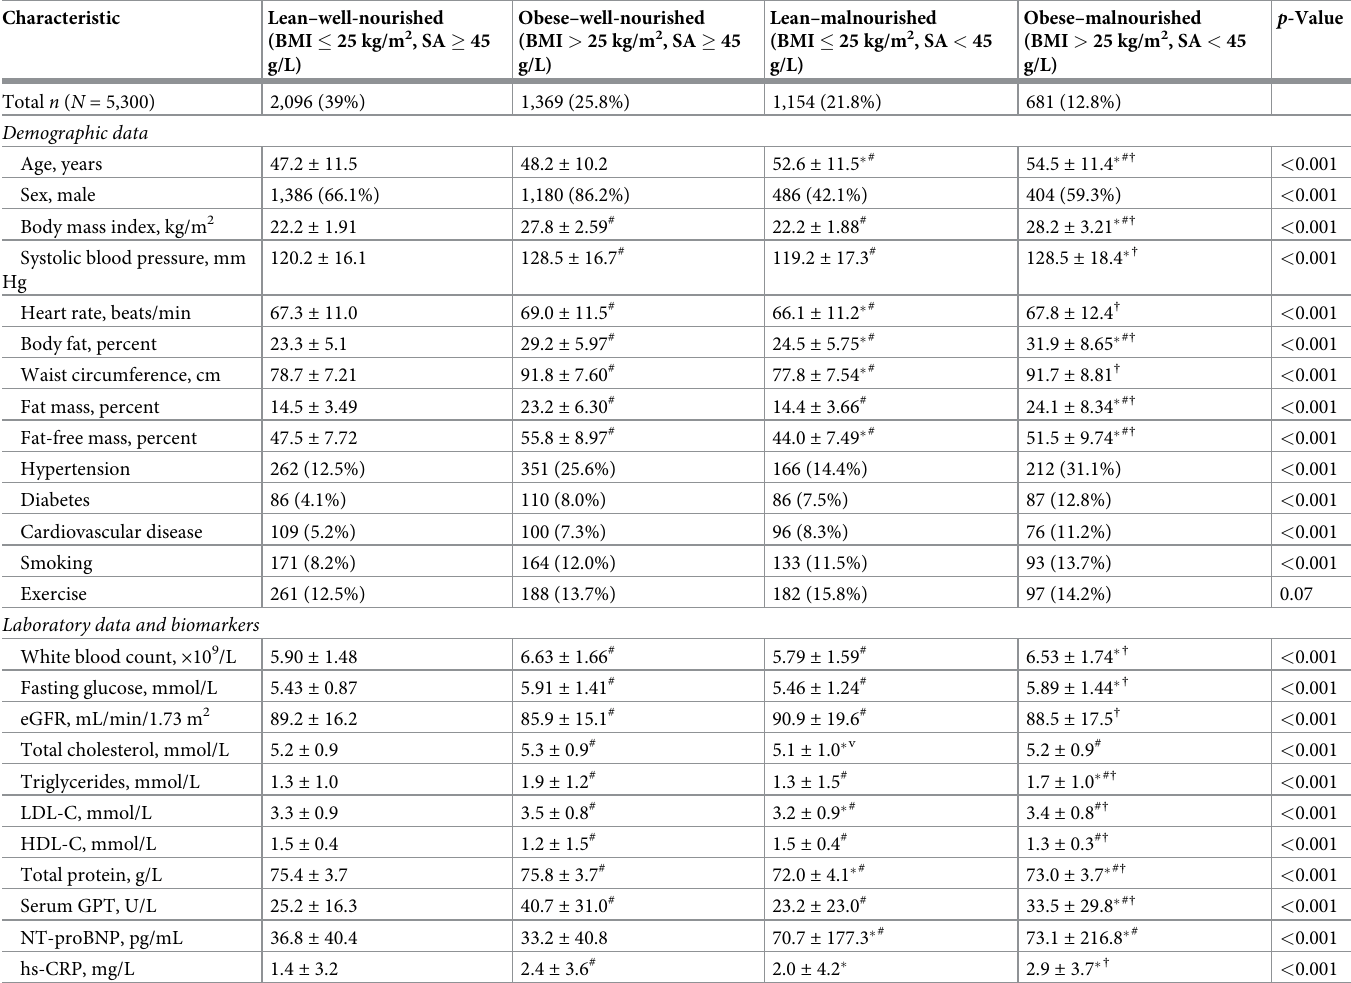
Table 1. Baseline demographics of study participants according to obesity and serum albumin categories.